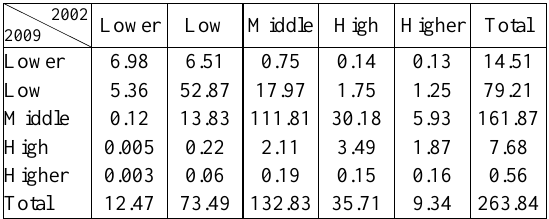
Table 4. The transfer matrix of soil area with different moisture levels from 2002 to 2009 (area/km 2 )